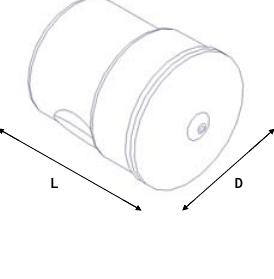
Figure 2. Asynchronous motor da 30 kW; L = 315 mm, D = 264 mm.